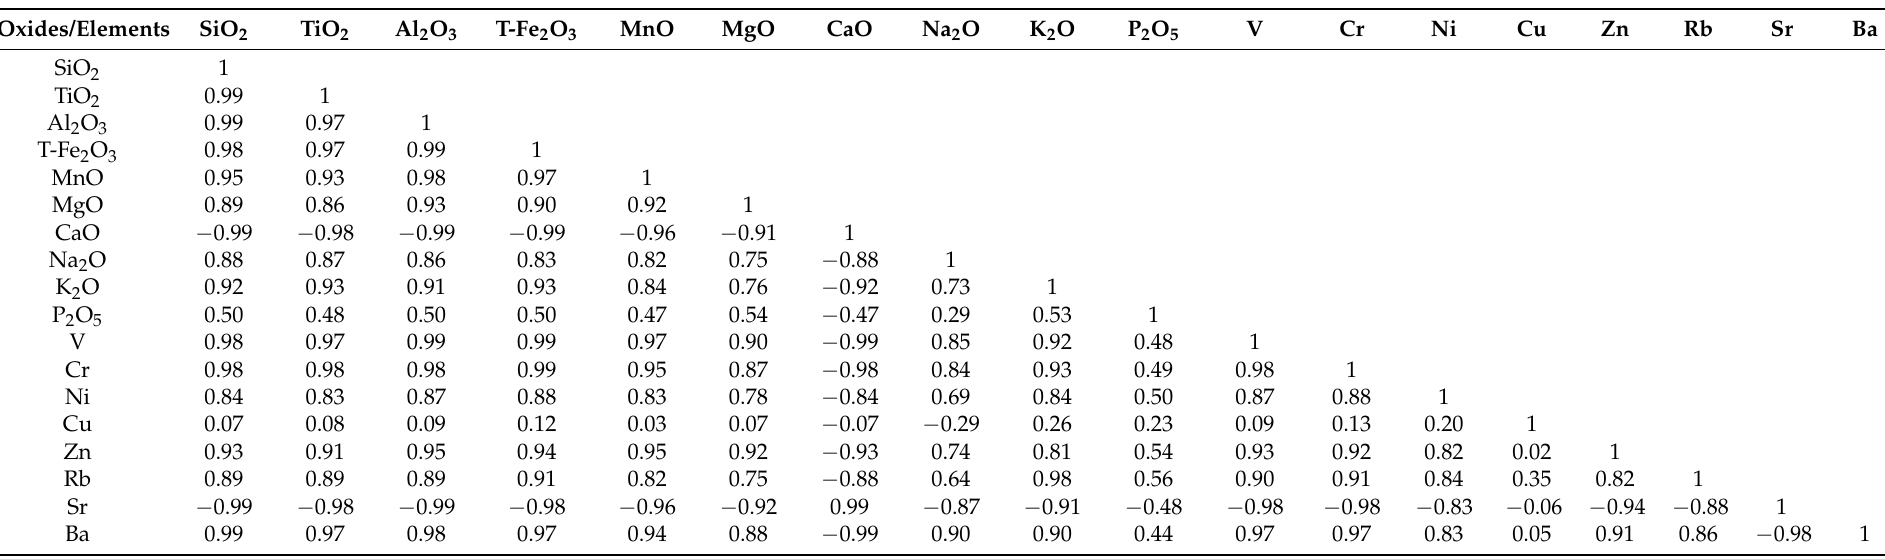
Table 3. Correlation matrix of oxides and minor and trace element concentrations in the bottom sediments (n = 46 samples) of Sharm